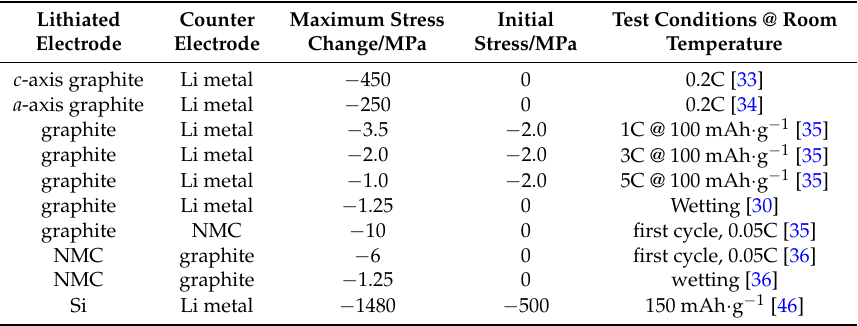
Table 3. Stress measurement data of composite electrodes for experimental Li-ion